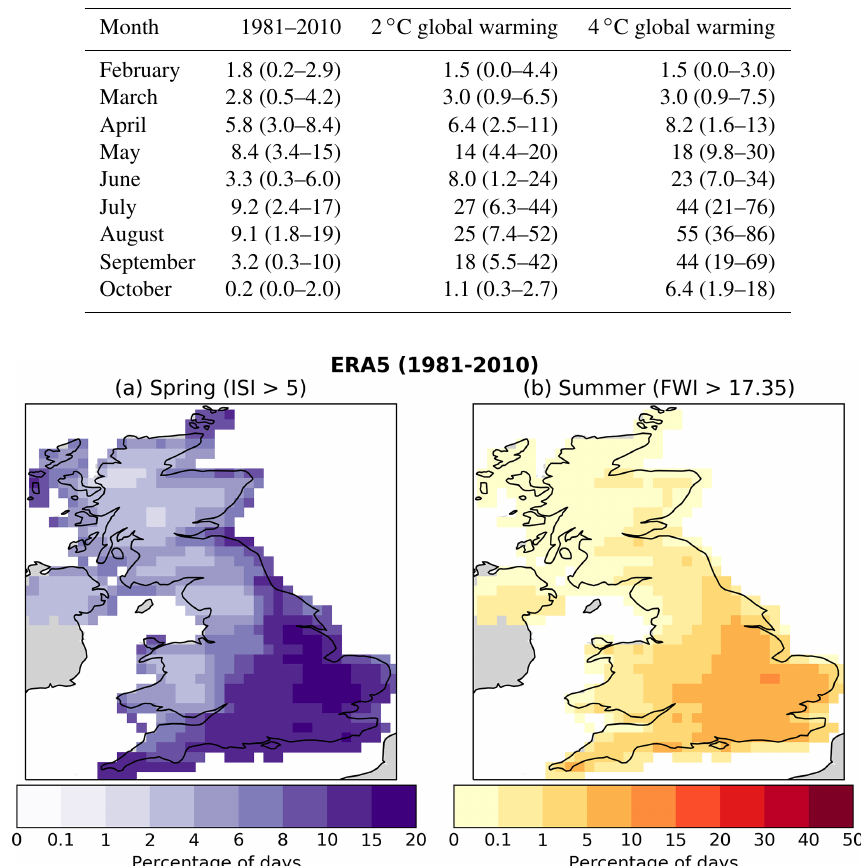
Figure 8. Percentage of days with dangerous fire weather for (a) spring (ISI > 5; at least high) and (b) summer (FWI > 17.35; at least very high). Based on the ERA5 reanalysis data for the 1981–2010